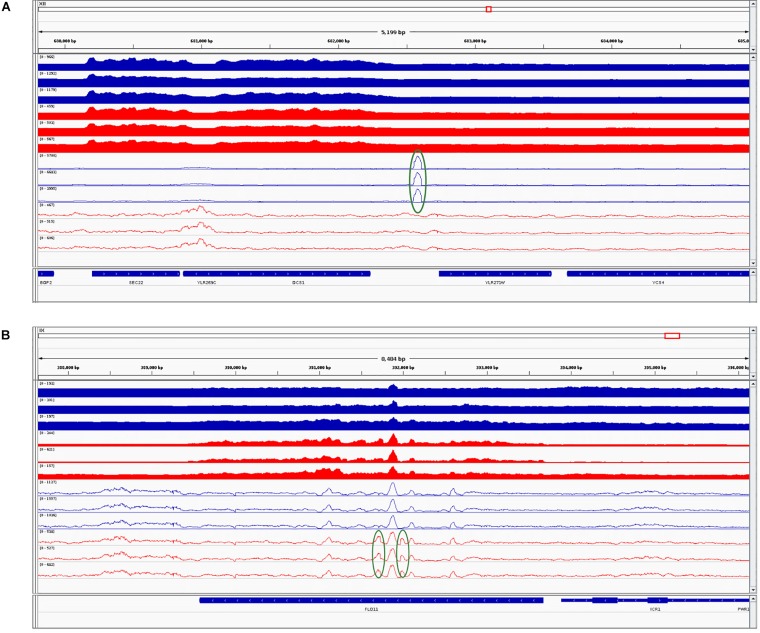
Integrative Genomic Viewer screenshots combining RNA sequencing (RNA-Seq) and assay for transposase-accessible chromatin using sequencing (ATAC-Seq) datasets for Saccharomyces cerevisiae (SC) and its counterpart in the hybrid. (A) The first identified differentially accessible region. (B) The second identified differentially accessible region. Blue tracks correspond to SC in the parental background and red tracks correspond to SC in the hybrid background. Filled tracks correspond to RNA-Seq data and contour tracks correspond to ATAC-Seq data. Regions with higher coverage are highlighted in green circles. The last track represents genomic features. Further description is given in the main text.